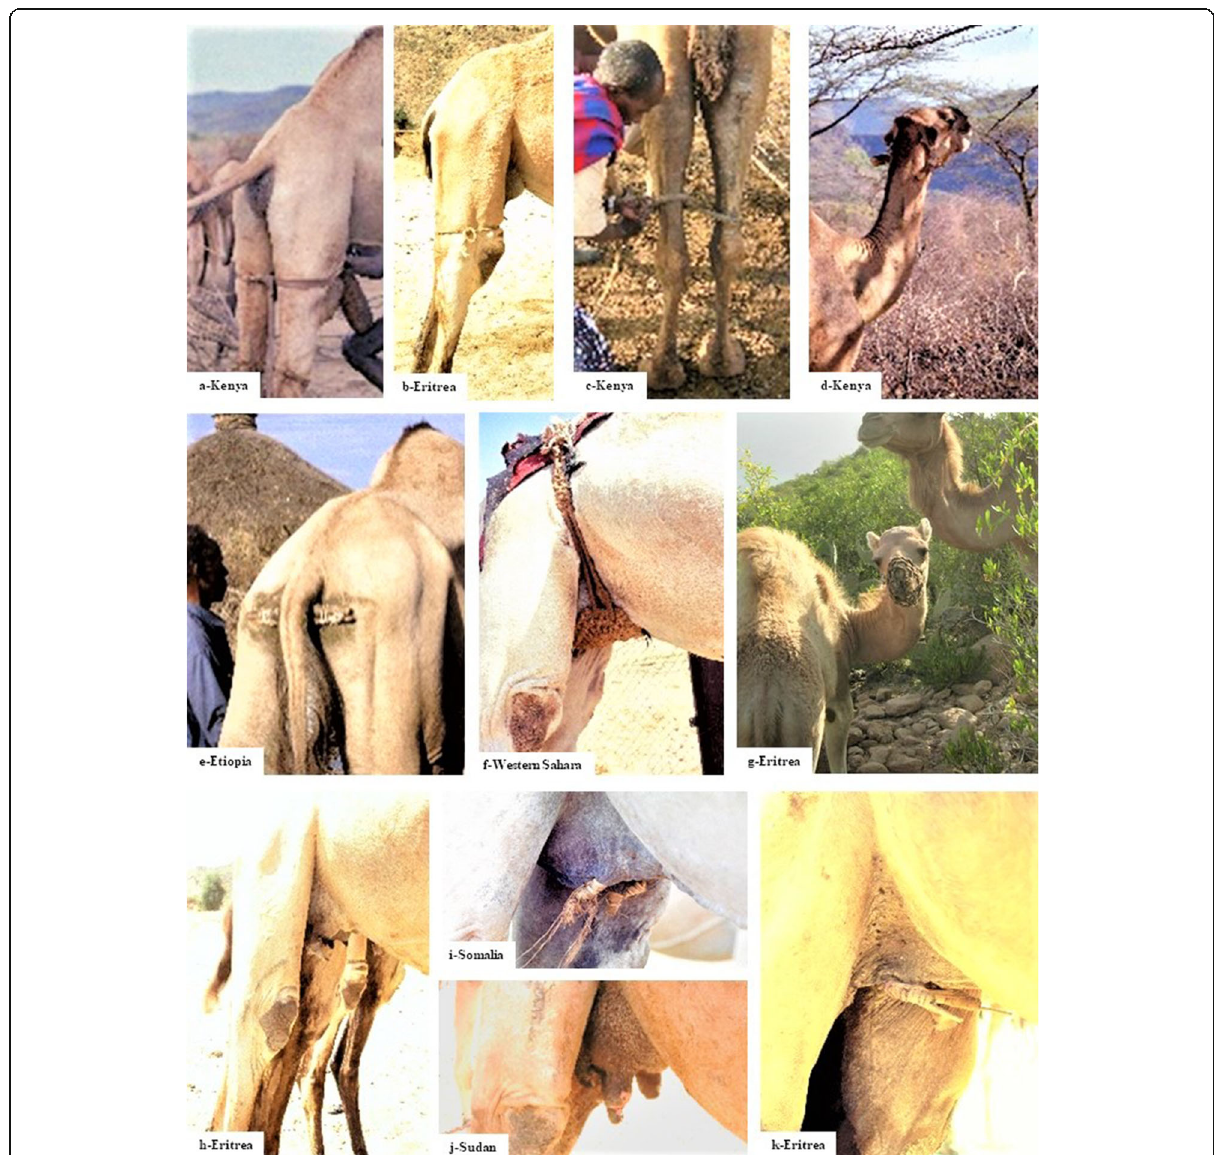
Fig. 6 Images of various camel milking and weaning practices used by nomadic camel pastoralists in a variety of countries (Dioli 2012,2013, Schwartz and Dioli 1992). a , c , d Kenya. b , g , h , k Eritrea. e Ethiopia. f Western Sahara. i Somalia. j